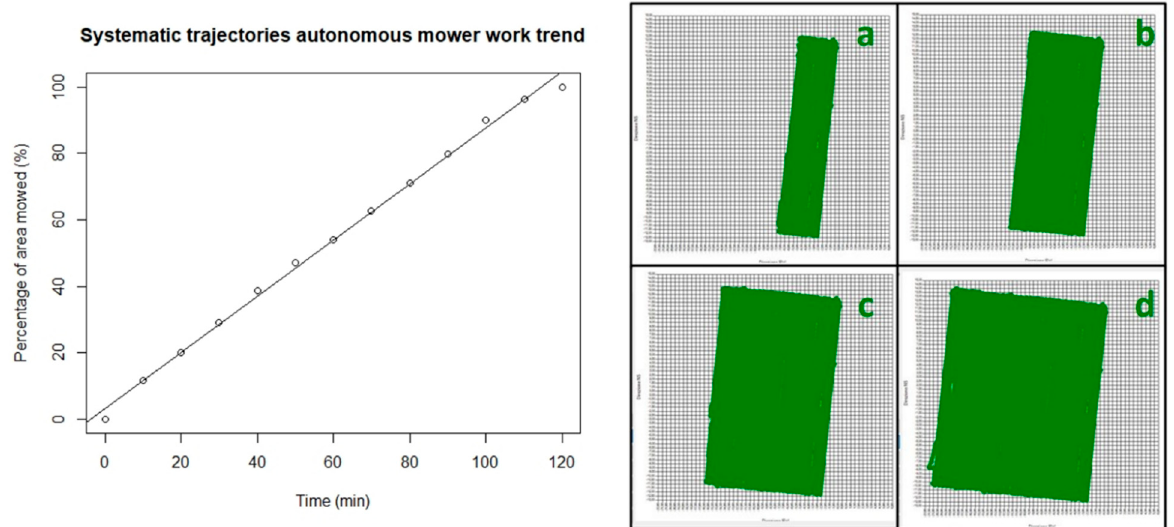
Figure 3. ( Left ) Data trend of mowed area percentage as a function of time (min) for autonomous mower with systematic trajectories working on 500 m 2 : observed values averaged across 4 replications (dots) and regression line (solid line). ( Right ) Custom-built software showing the mowed area on 5 October 2020 at different time intervals: ( a ) 30 min; ( b ) 60 min; ( c ) 90 min; ( d ) 120 min.